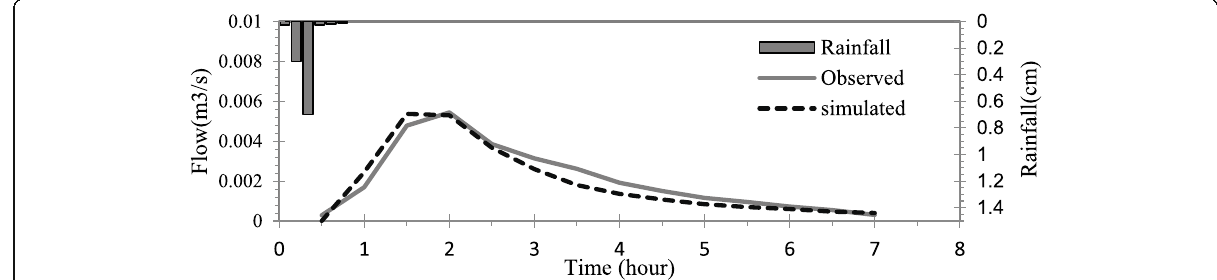
Fig. 5 Comparison of simulated and observed hydrographs derived from calibration, run for the rainfall event of